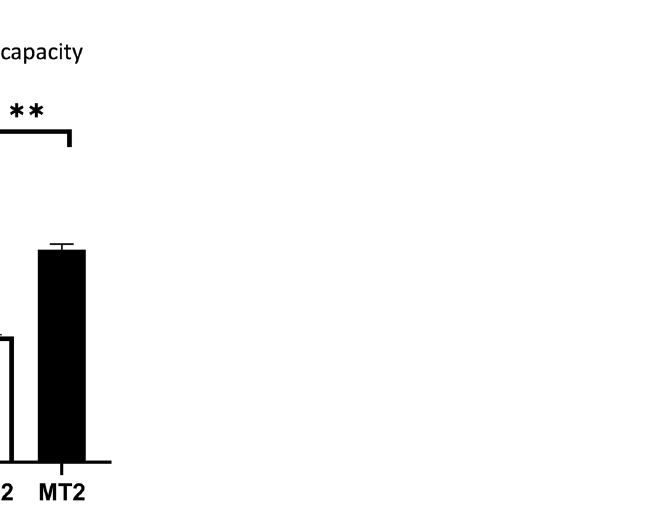
Figure 9. The contents of the plant hormones MT, IAA, ZR, GA3, and ABA were determined using icELISA. Values are means ± SD of three biological replicates. Bars indicate standard errors (n = 3). Student’s t test, **P < 0.01.